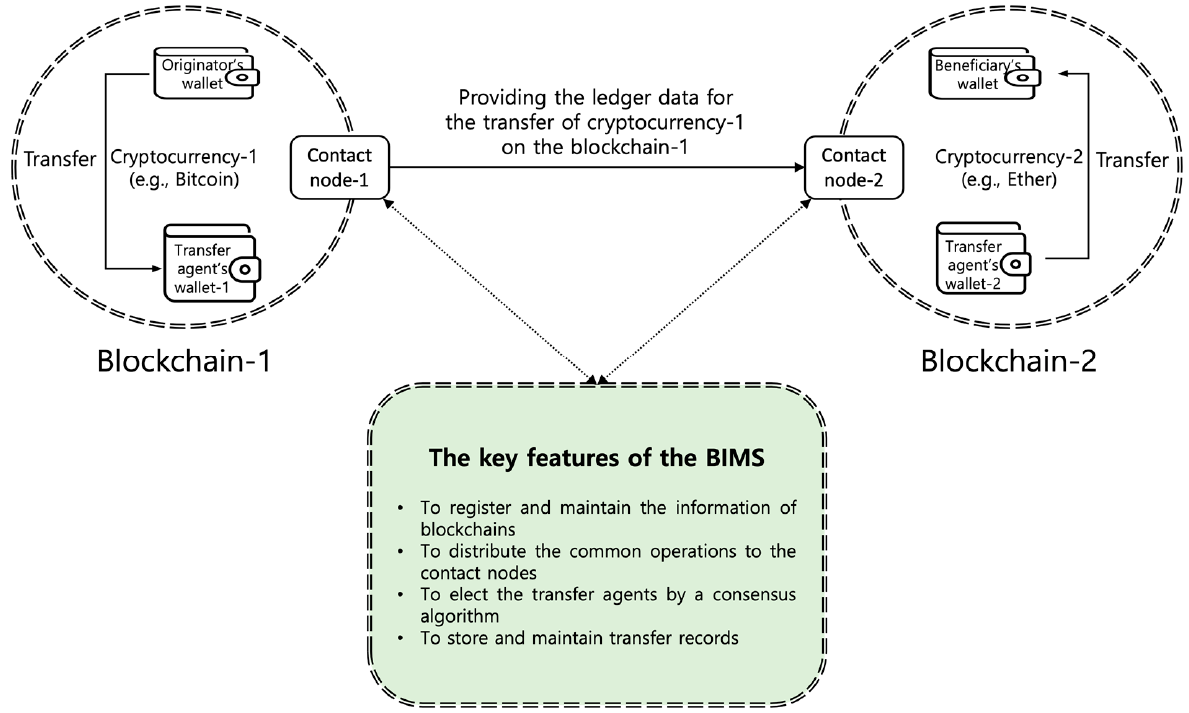
Figure 3. The service model for the transfer between cryptocurrency-1 and cryptocurrency-2.